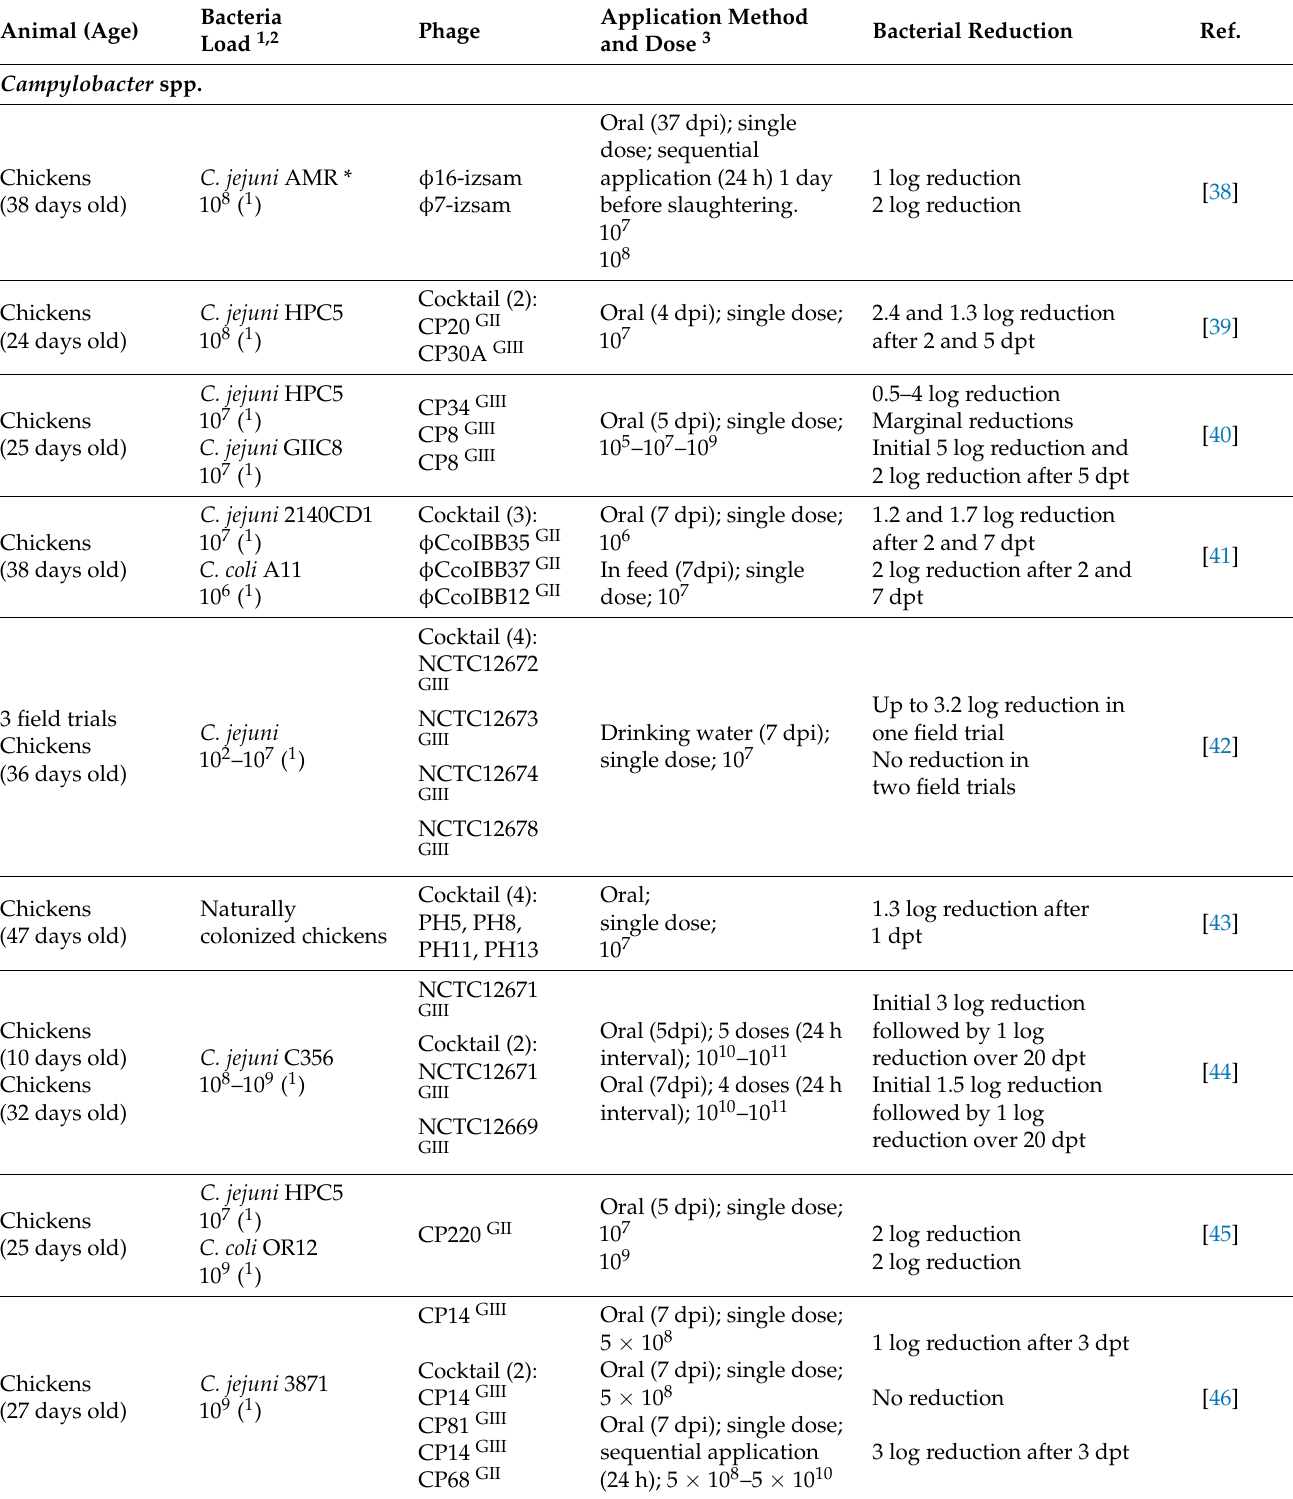
Table 1. Examples of the use of bacteriophages for reducing the incidence of Campylobacter spp. and Salmonella spp. in broilers (pre-harvest stages of